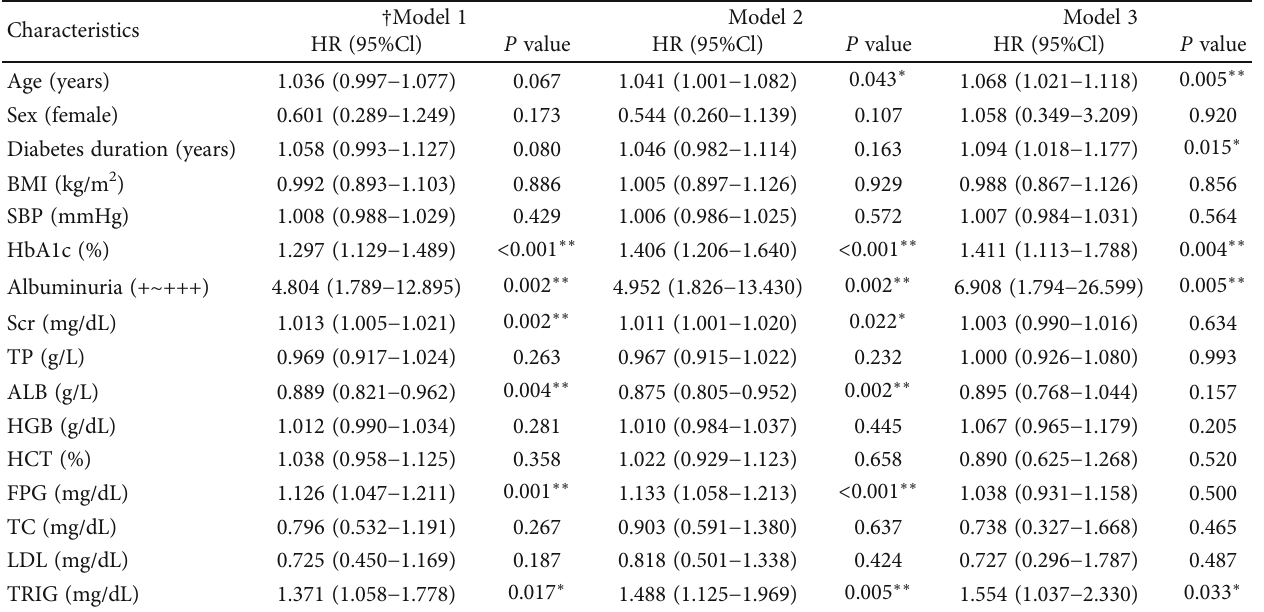
Table 2: Cox regression for DR development with clinical characteristics. † Model 1: univariate cox regression. ‡ Model 2: age and sex were adjusted by each other; all other variables were adjusted by age and sex. §Model 3: all variables were entered into this multivariate regression analysis model. The outcomes of Cox regressions were expressed as HRs, 95% CI, and P value. ∗ P < 0 : 05 , ∗∗ P < 0 : 01 . DR: diabetic retinopathy; BMI: body mass index; SBP: systolic blood pressure; DBP: diastolic blood pressure; HbA1c: hemoglobin A1c; Scr: serum creatinine; eGFR: estimated glomerular fi ltration rate; TP: total protein; ALB: serum albumin; HGB: hemoglobin; HCT: hematocrit; FPG: fasting plasma glucose; TC: total cholesterol; LDL: low-density lipoprotein; TRIG, triglyceride.